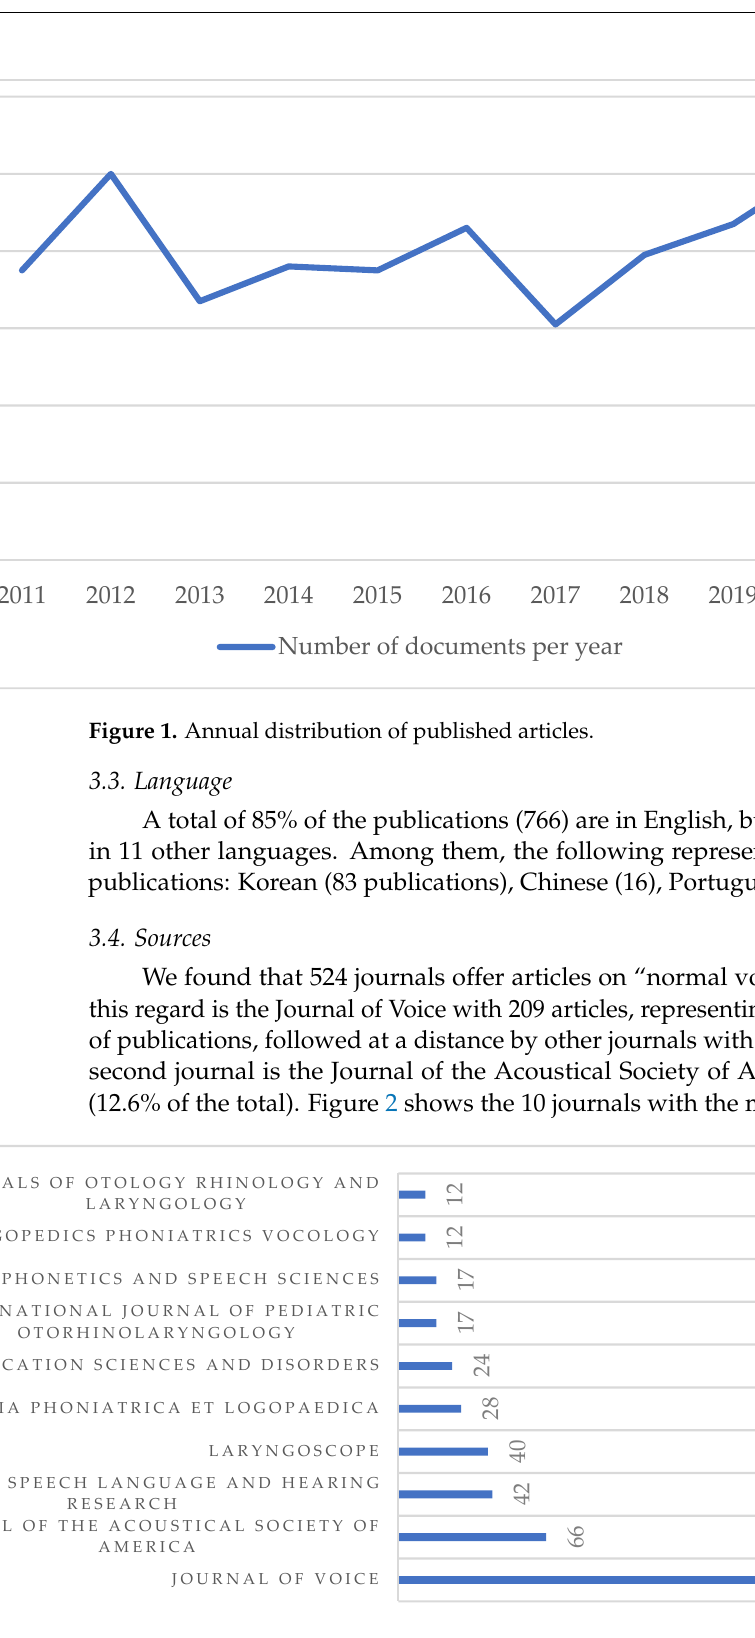
Figure 1. Annual distribution of published articles.